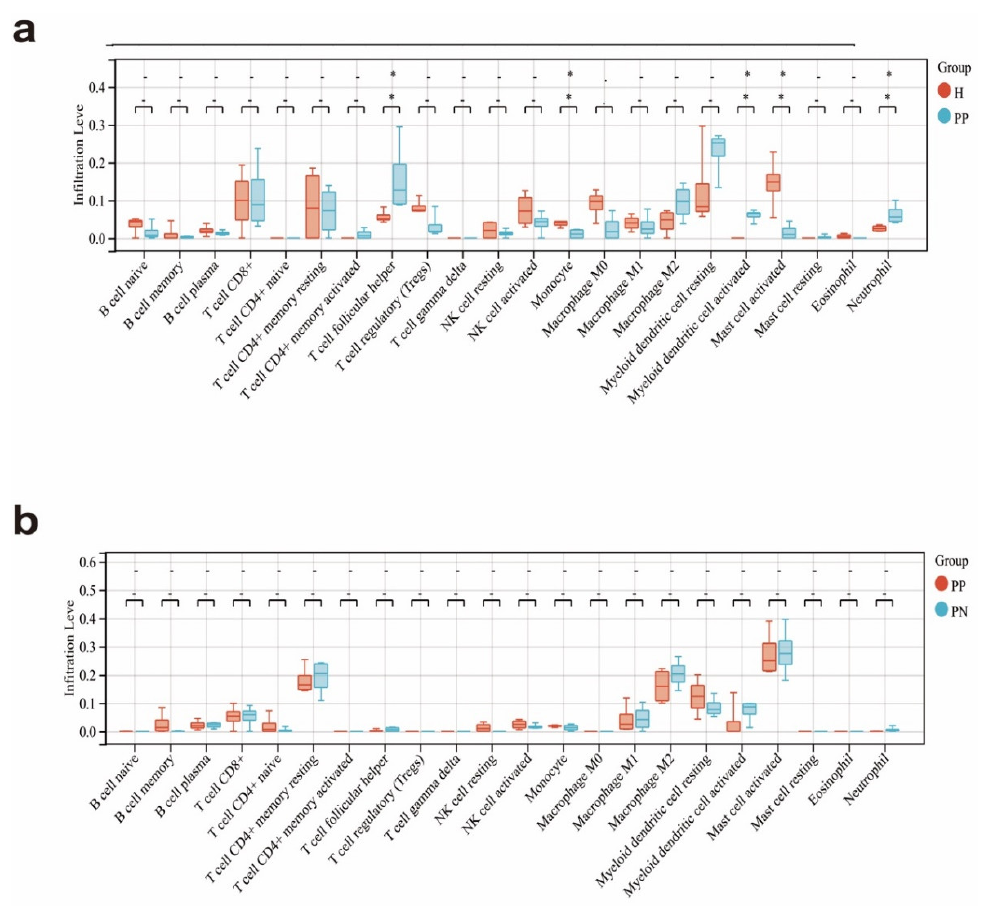
Figure 5. 22 immunological cells were represented on a violin chart. ( a ) Data was from PP and normal control groups and ( b ) Data was from PP and PN. The black mark denoted a substantial distinction between the two sample groups. * p < 0.05.